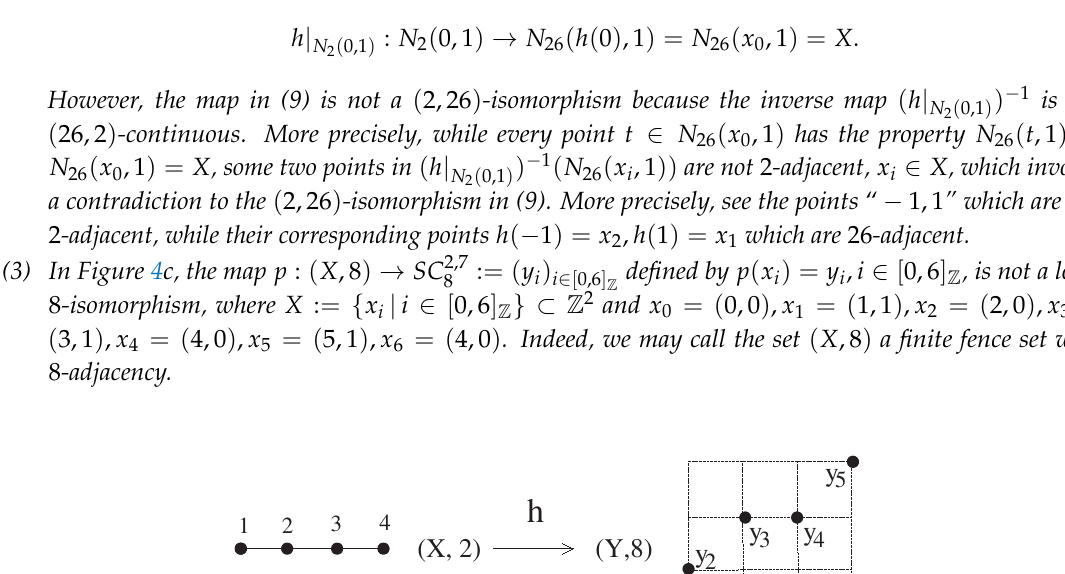
Figure 3. Explanation of the map h referred to in the proof of Corollary 3, where ( Y ,8 ) is a portion of Z 2 with 8-adjacency.